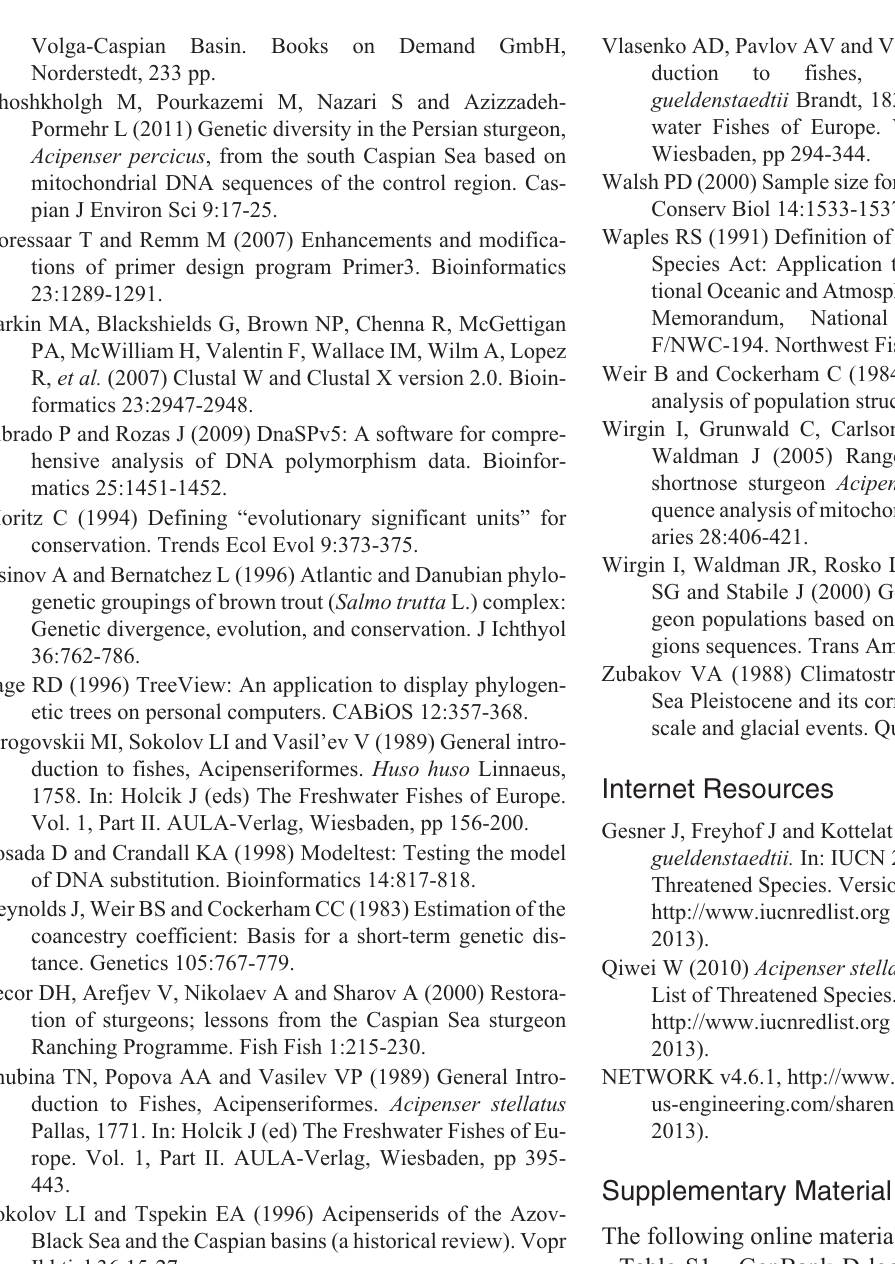
- Table S1 - GenBank D-loop sequences from sturgeons subspecies. - Figure S1 - Variable sites in unique haplotypes of A. gueldenstaedtii D-loop region. - Figure S2 - Variable sites in unique haplotypes of A. stellatus D-loop region. - Figure S3 - Variable sites in unique haplotypes of H. huso D-loop